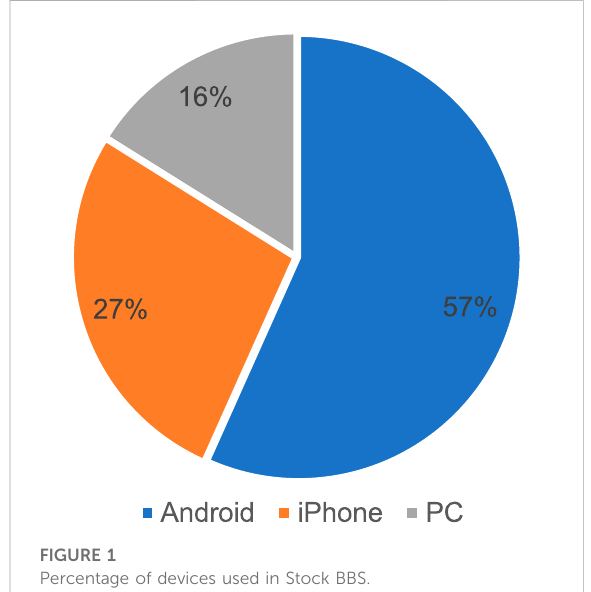
FIGURE 1 Percentage of devices used in Stock BBS.